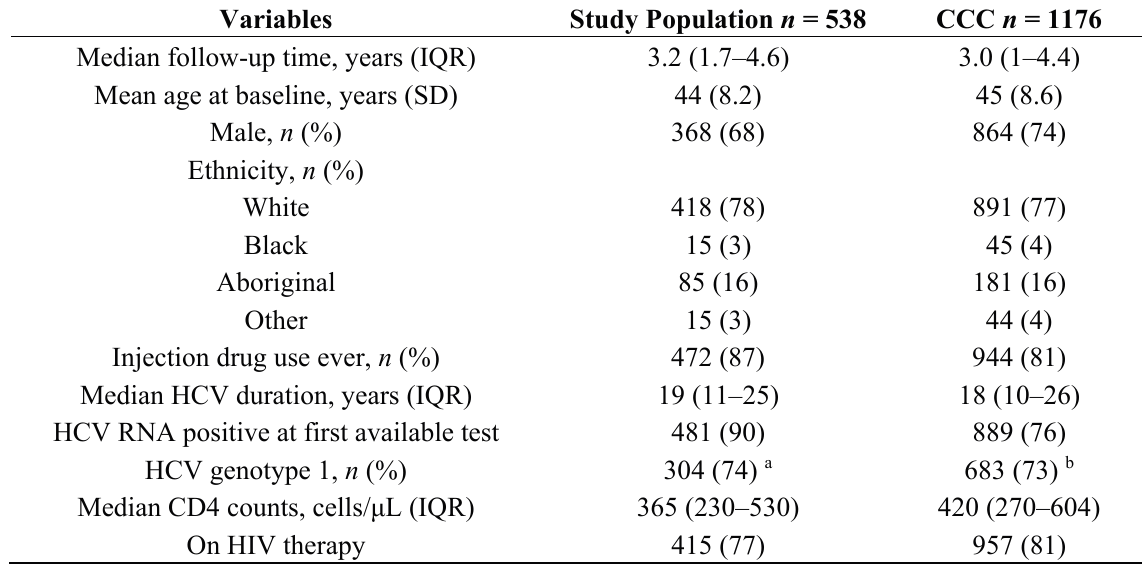
Table 1. Baseline characteristics of IFNL3-spontaneous clearance study population compared with the Canadian Co-infection Cohort (CCC) source population.